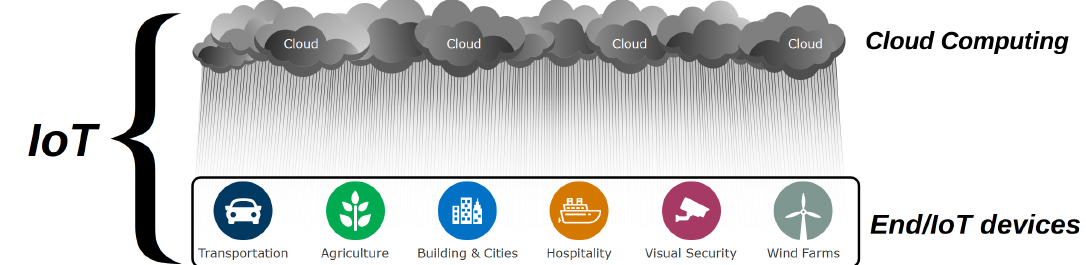
Figure 1. A broader definition of IoT (adapted from [21]): a two layered architecture in which End/IoT devices strongly rely on the